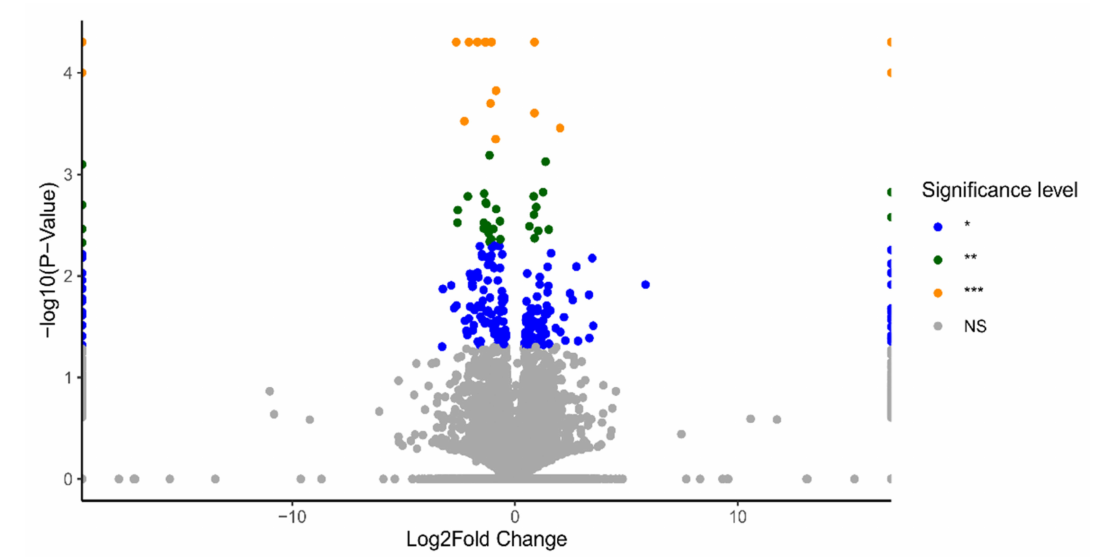
from the statistical significance data ( p -value) and the magnitude of change (fold change) between two conditions: BPA 10 nM vs. control (Figure 1) and BPA 100 nM vs. control (Figure 2).